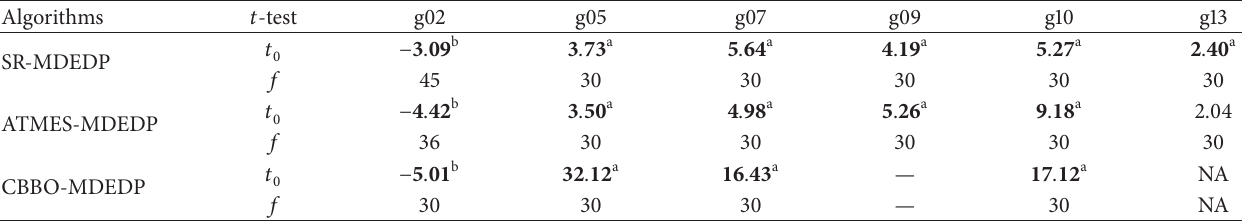
Table 3: Results of the approximate two-sample 𝑡 -test between the other three algorithms and our MDEDP for six instances. Algorithms 𝑡 -test